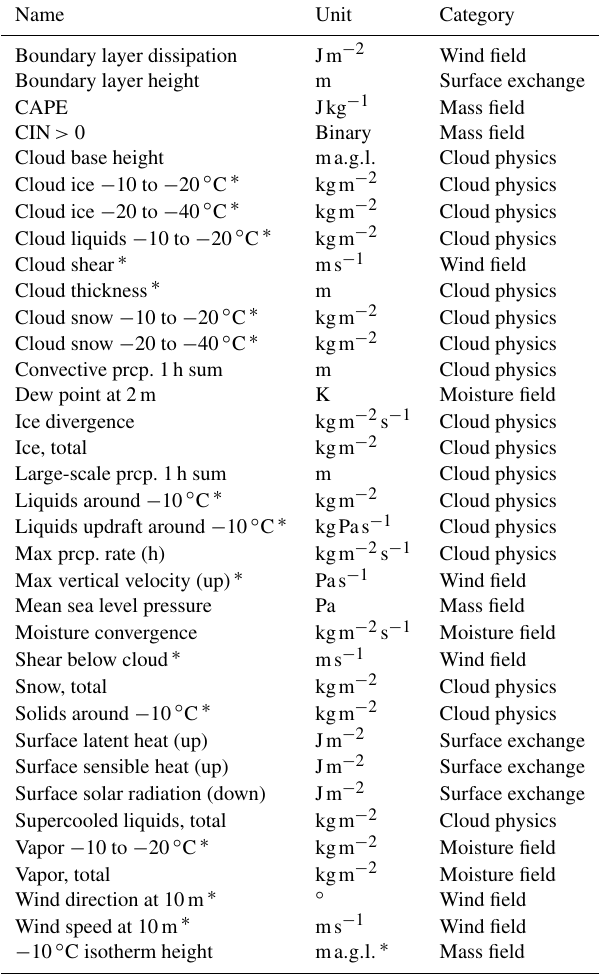
Table 1. ERA5 variables used in this study. Variables derived from other ERA5 variables are marked by an asterisk ( ∗